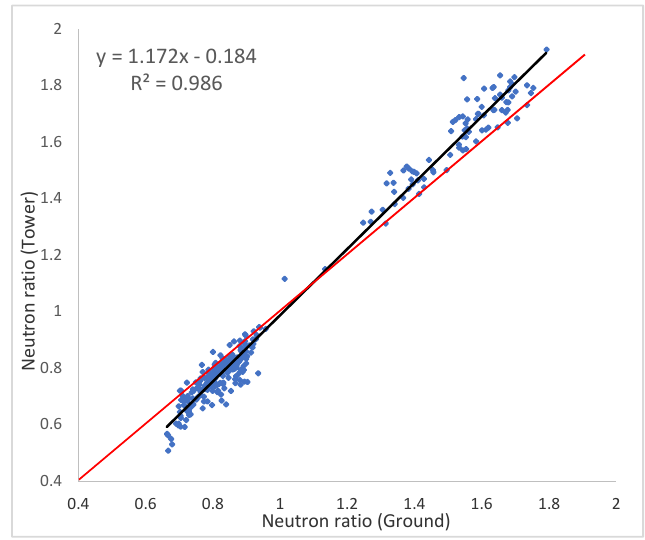
Figure 9. Neutron ratio of the ground CRNS (x-axis) against the neutron ratio of the tower CRNS (y-axis), in the Two-Streams Catchment.